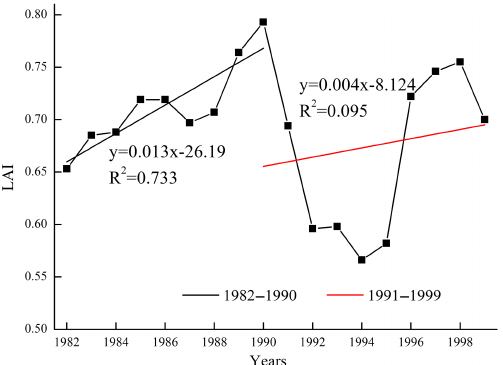
Figure 11. Trend in the LAI from 1982 to